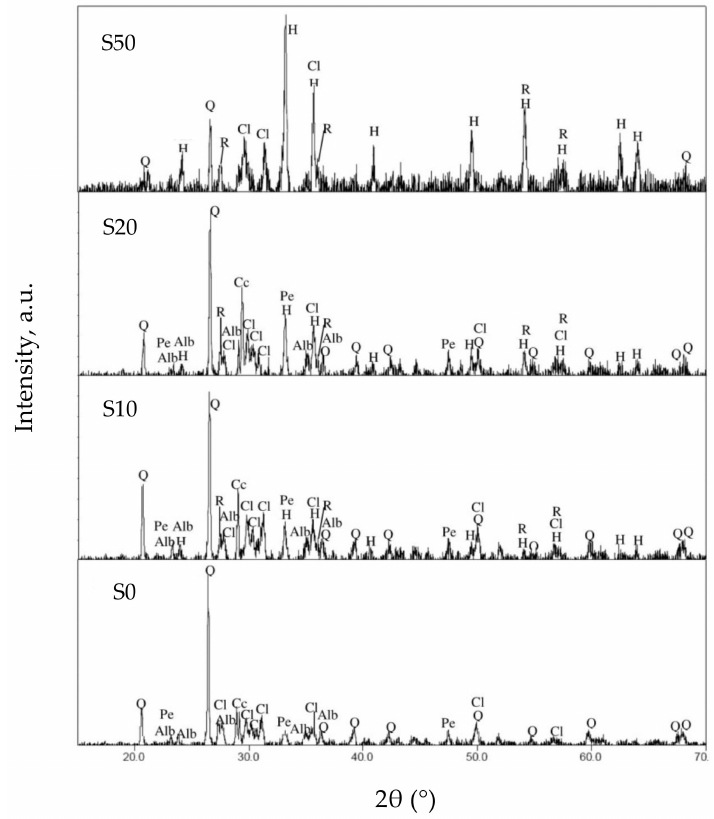
Figure 3. XRD patterns of coated surfaces, after annealing at 600 ◦ C for 1 h. Abbreviations — Q: quartz, Alb: albite, Cl: clinopyroxene (aluminium diopside), Cc: calcite, H: hematite, Pe: perovskite, R: